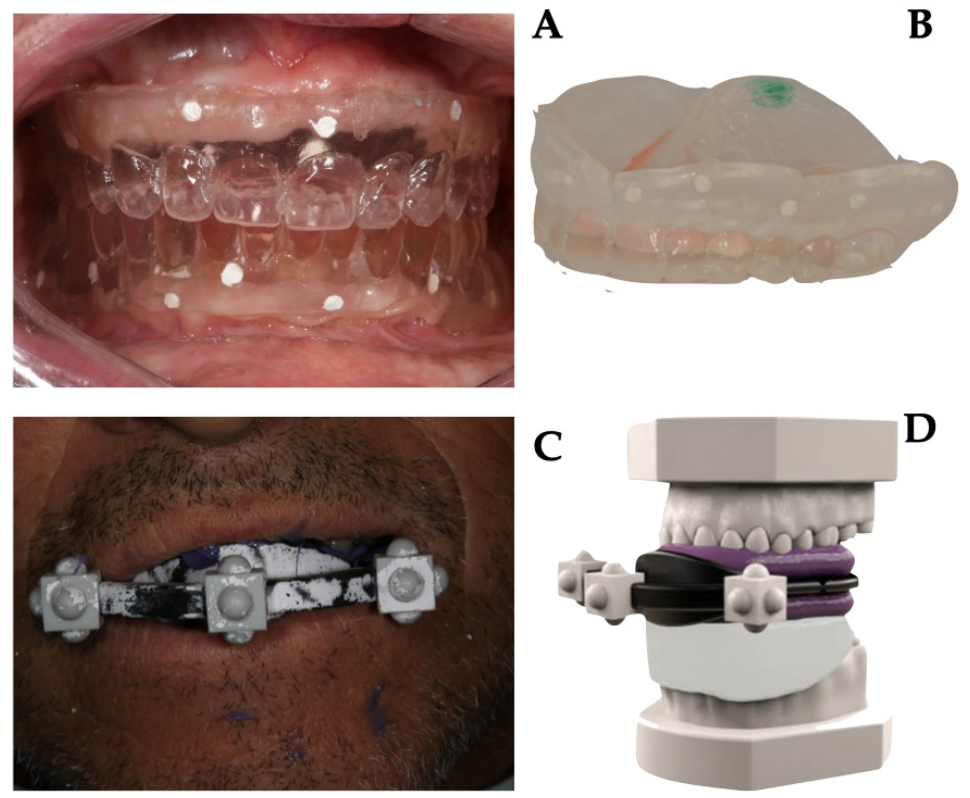
Figure 1. Data acquisition protocol: ( A ) intraoral position of resin duplicates of patient’s prosthesis. Gutta-percha markers were inserted into 1 mm deep niches on the prosthesis (on the vestibular and palatal–lingual sides). The patient underwent CBCT (Cone Beam Computed Tomography) scanning while wearing the denture; ( B ) a second CBCT of the denture alone was performed; ( C ) a duplicate of the prosthesis was attached to an extraoral stent with three-dimensional radiopaque marks. The whole was stabilized in the mouth with a radiolucent occlusal index. The patient underwent CBCT scanning while wearing the duplicate, stent, and stabilization index; ( D ) extraoral scans were performed using a laboratory scanner of all collected data.